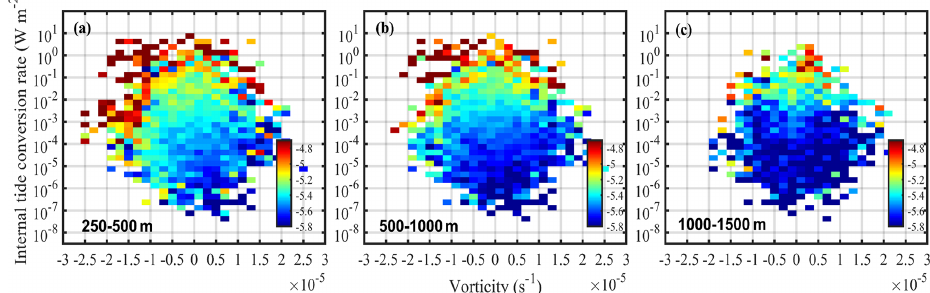
Figure 10. The averaged diapycnal diffusivities as a function of vorticity and internal tides conversion rate between (a) 250–500m, (b) 500–1000m, and (c) 1000–1500m.